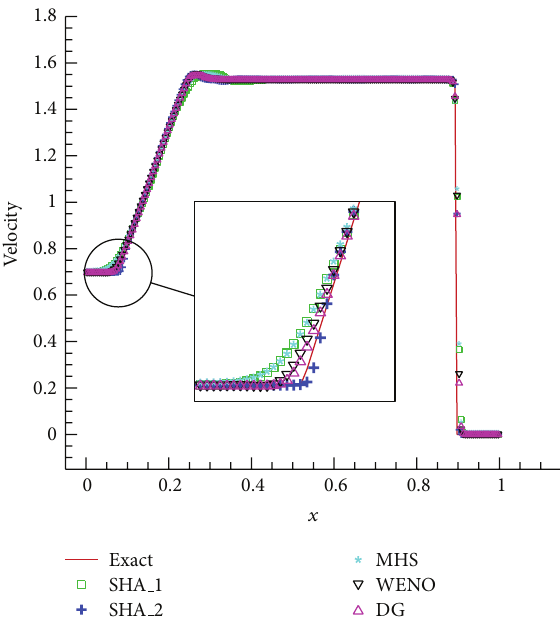
Figure 16: Density comparison of schemes at time 0.16 units for Lax problem.